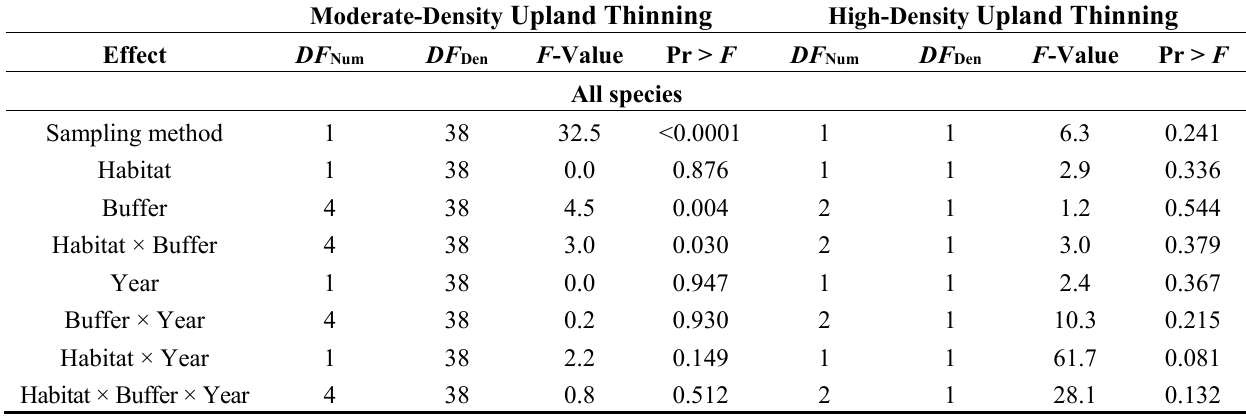
Table 4. Results from mixed model analyses of variance testing for the effects of riparian buffer treatments (1Tree, Variable, Streamside and no-buffer/thin-through vs. untreated controls) prior to and following the second thinning treatment (year), while controlling for sampling method (hand search vs. electrofishing) and habitat structure (NMS Axis 1 scores) on stream-associated vertebrate species; DF Num = degrees of freedom for the numerator; DF Den = degrees of freedom for the denominator; Pr = probability. Moderate-Density Upland Thinning High-Density Upland Thinning Effect DF